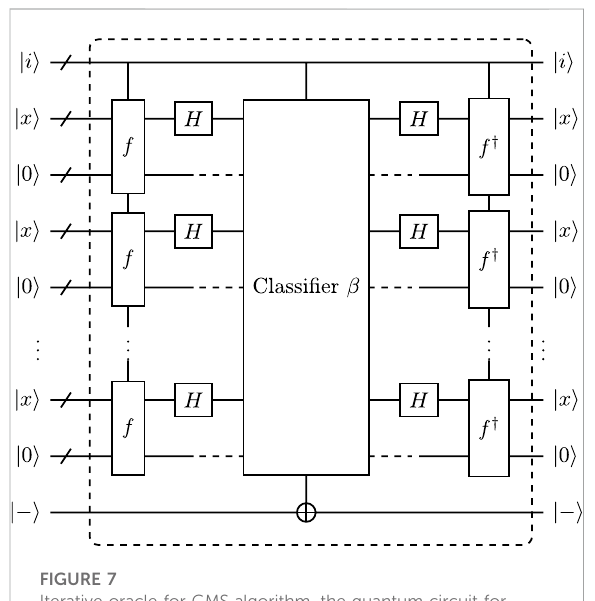
FIGURE 7 Iterative oracle for GMS algorithm, the quantum circuit for classi fi er β isgiveninSupplementaryFigureS5ofSupplementaryB